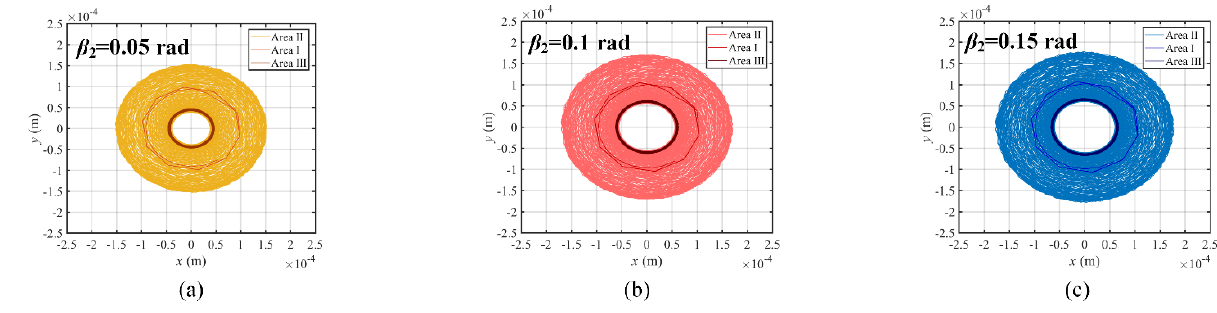
Figure 13. The axis trajectory of the hydro-turbine runner under different blade exit flow angles. ( a ) β 2 = 0.05 rad; ( b ) β 2 = 0.1 rad; ( c ) β 2 = 0.15 rad.